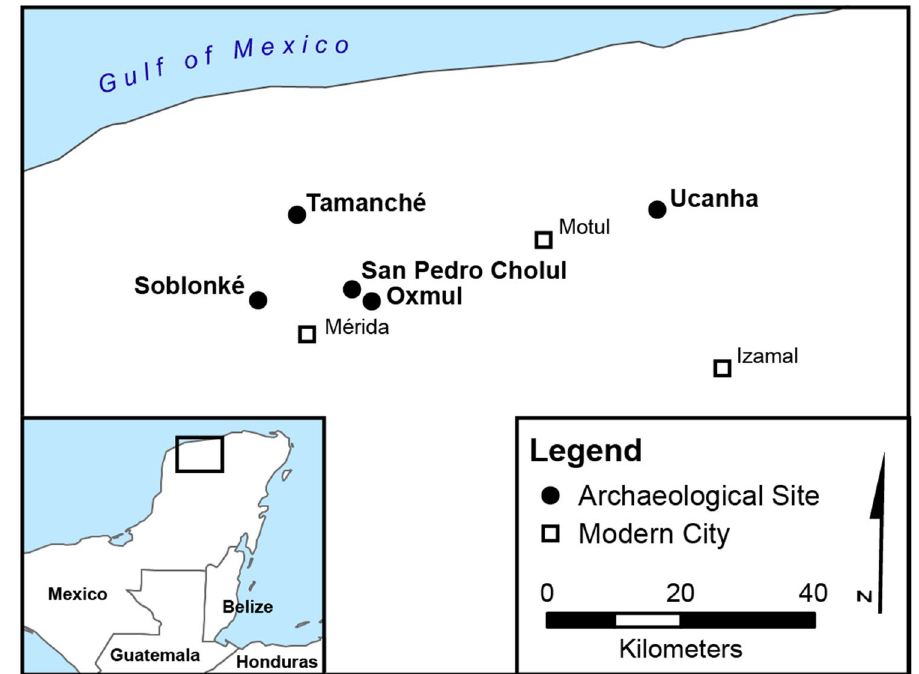
Figure 1. Map showing the archaeological sites of artifact recovery (generated via ArcGIS Desktop 10.7.1 [Environmental Systems Research Institute, 2020, Redlands, CA. https ://deskt op.arcgi s.com/en/] using data from Natural